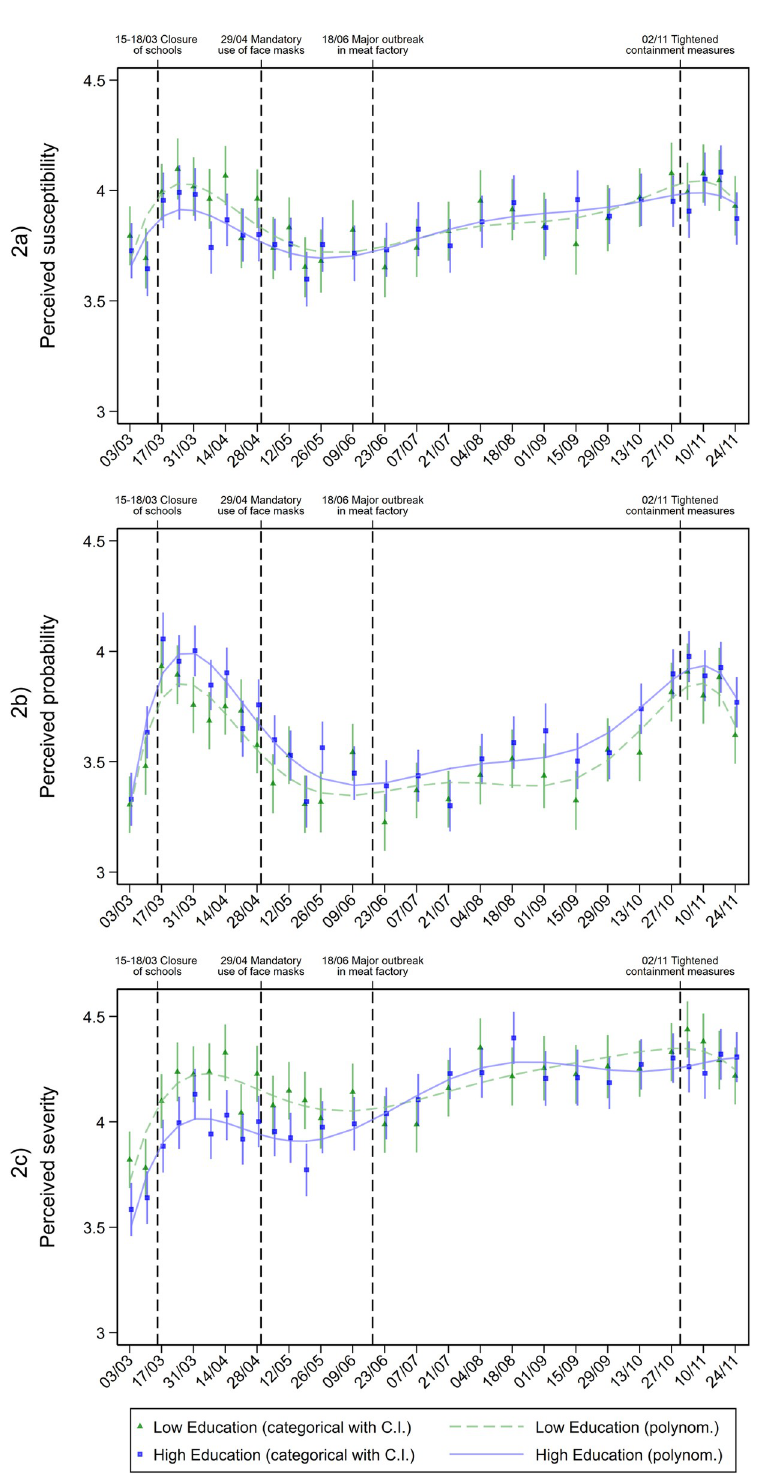
Fig 2. Cognitive dimensions of risk perception in individuals with different education levels during the pandemic. Adjusted predictions from linear regressions with interaction between education level and calendar week (categorial and metric), adjusted for age group, gender, repeat respondent, community size, and federal state.